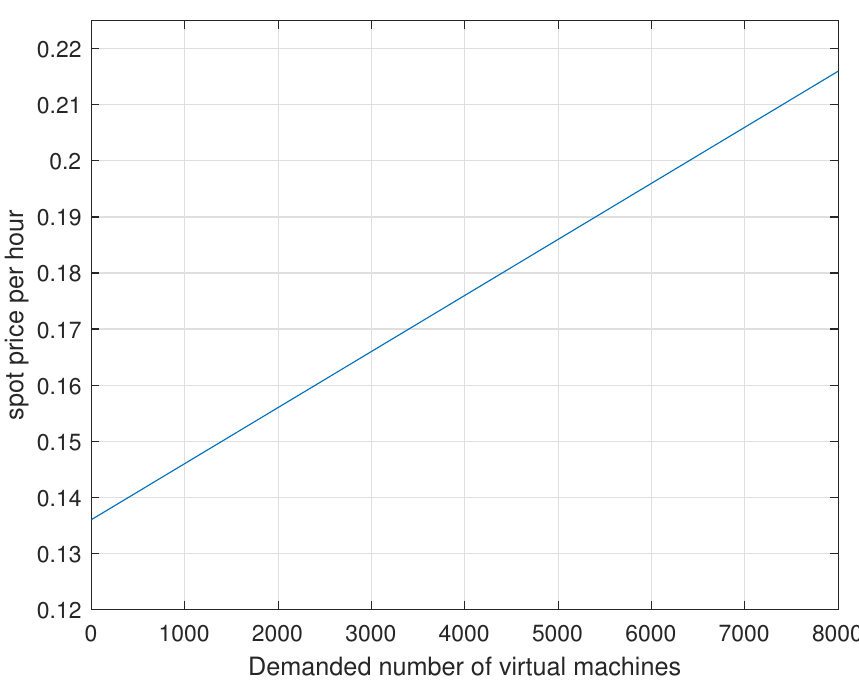
Figure 3. Spot prices per hour vs. the number of demanded virtual machines (VMs) with the hourly usage cost as 0.136 USD/h and the α parameter as